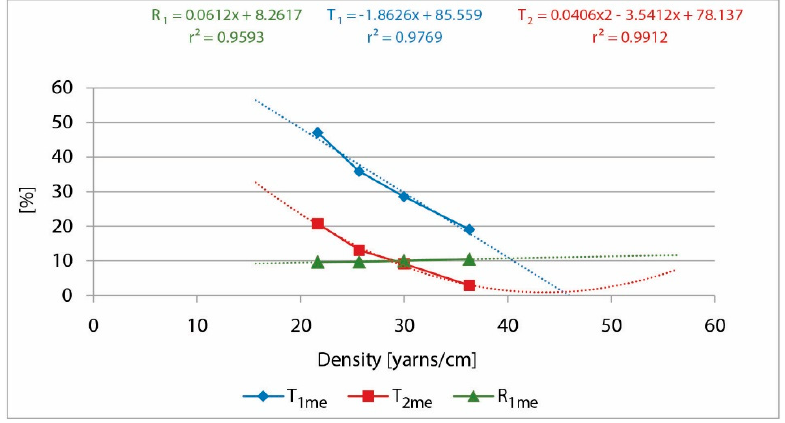
Figure 7. T and R of UV radiation of single-layer and double-layer CO samples, depending on the thread density, with the corresponding linear, polynomial equations, and the coefficient of